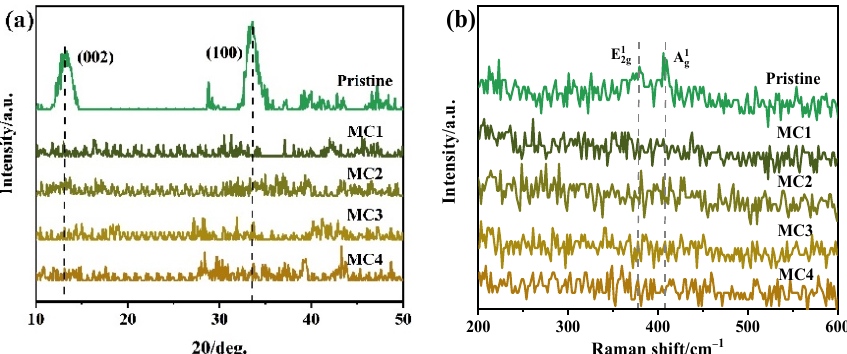
Figure 2. XRD patterns ( a ) and Raman spectra ( b ) of MOST/C nano-multilayer films before and after irradiation.